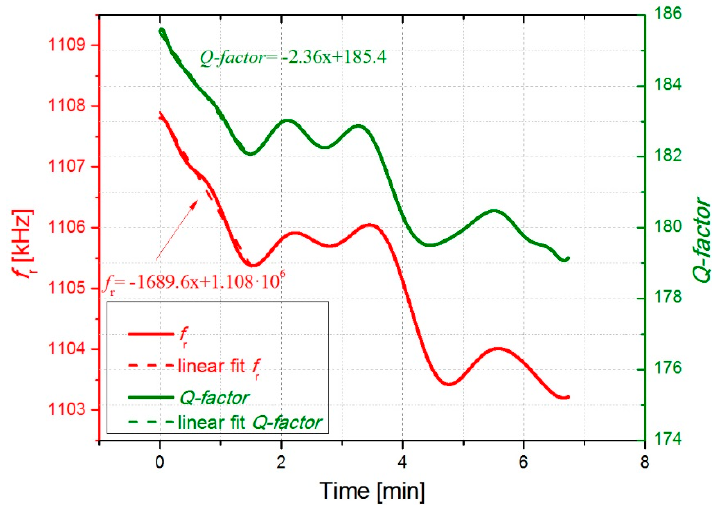
Figure 10. Closed loop measurement showing the evolution of the resonant parameters with the deposition of particles from two cigarettes.